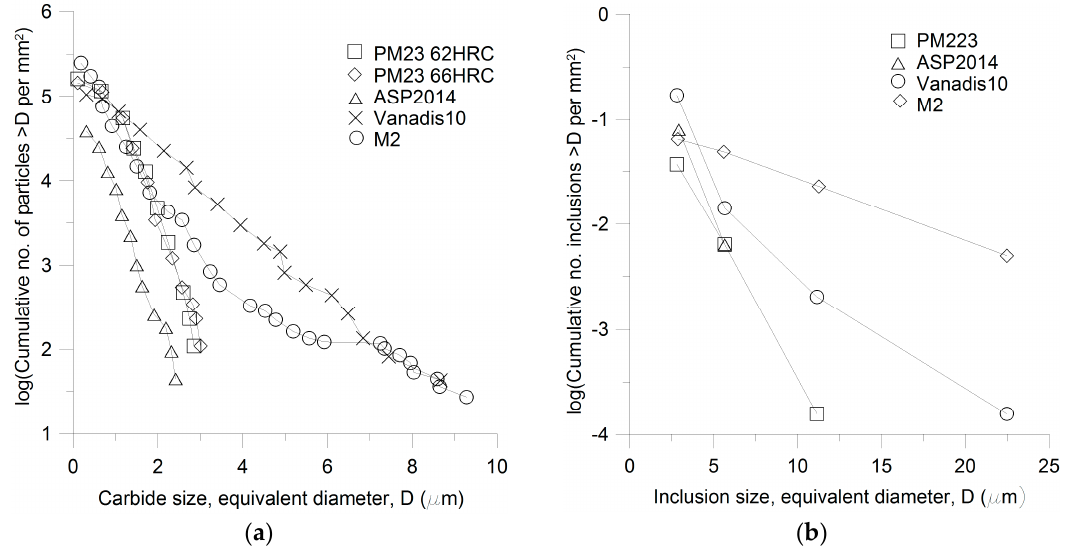
Figure 11. ( a ) Carbide size distribution for various tool steels [22]; ( b ) Inclusion size distribution for various tool steels [22].